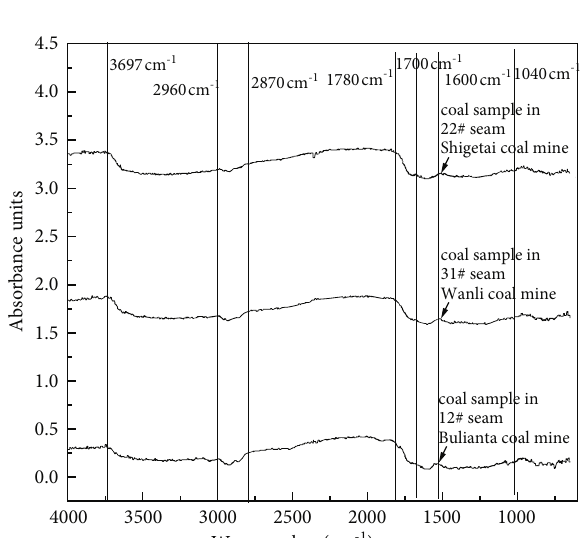
Figure 4: Infrared spectra for three coal samples taken from the Shendong mining